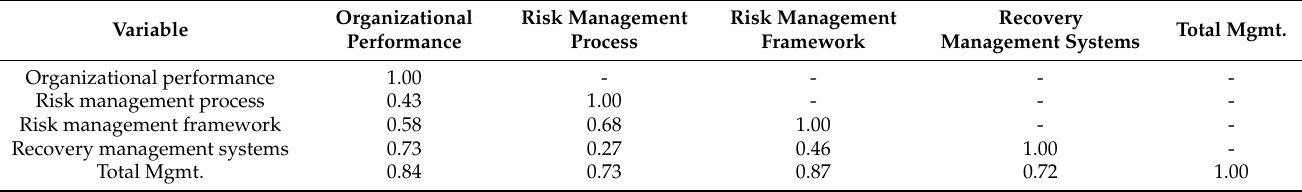
Table 8. The results of the Spearman correlation between scales of risk management and organiza- tional performance